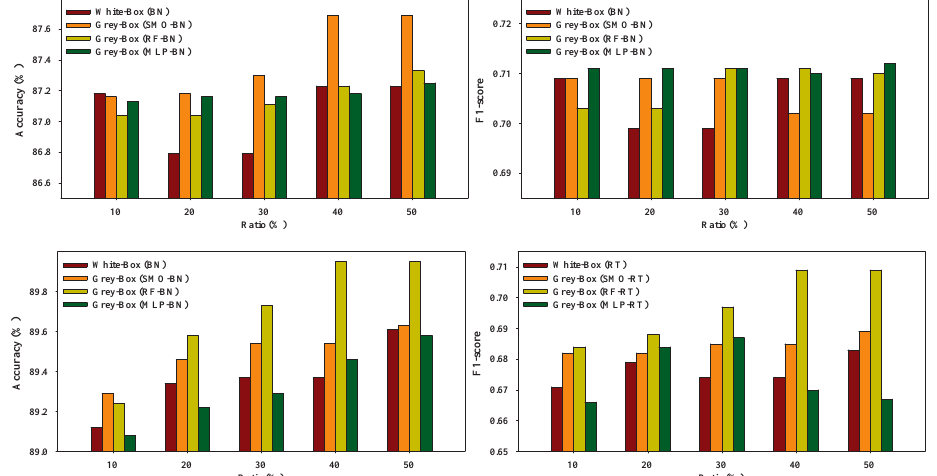
Figure 6. Box-plot with performance evaluation of Grey-Box and White-Box models for Bank